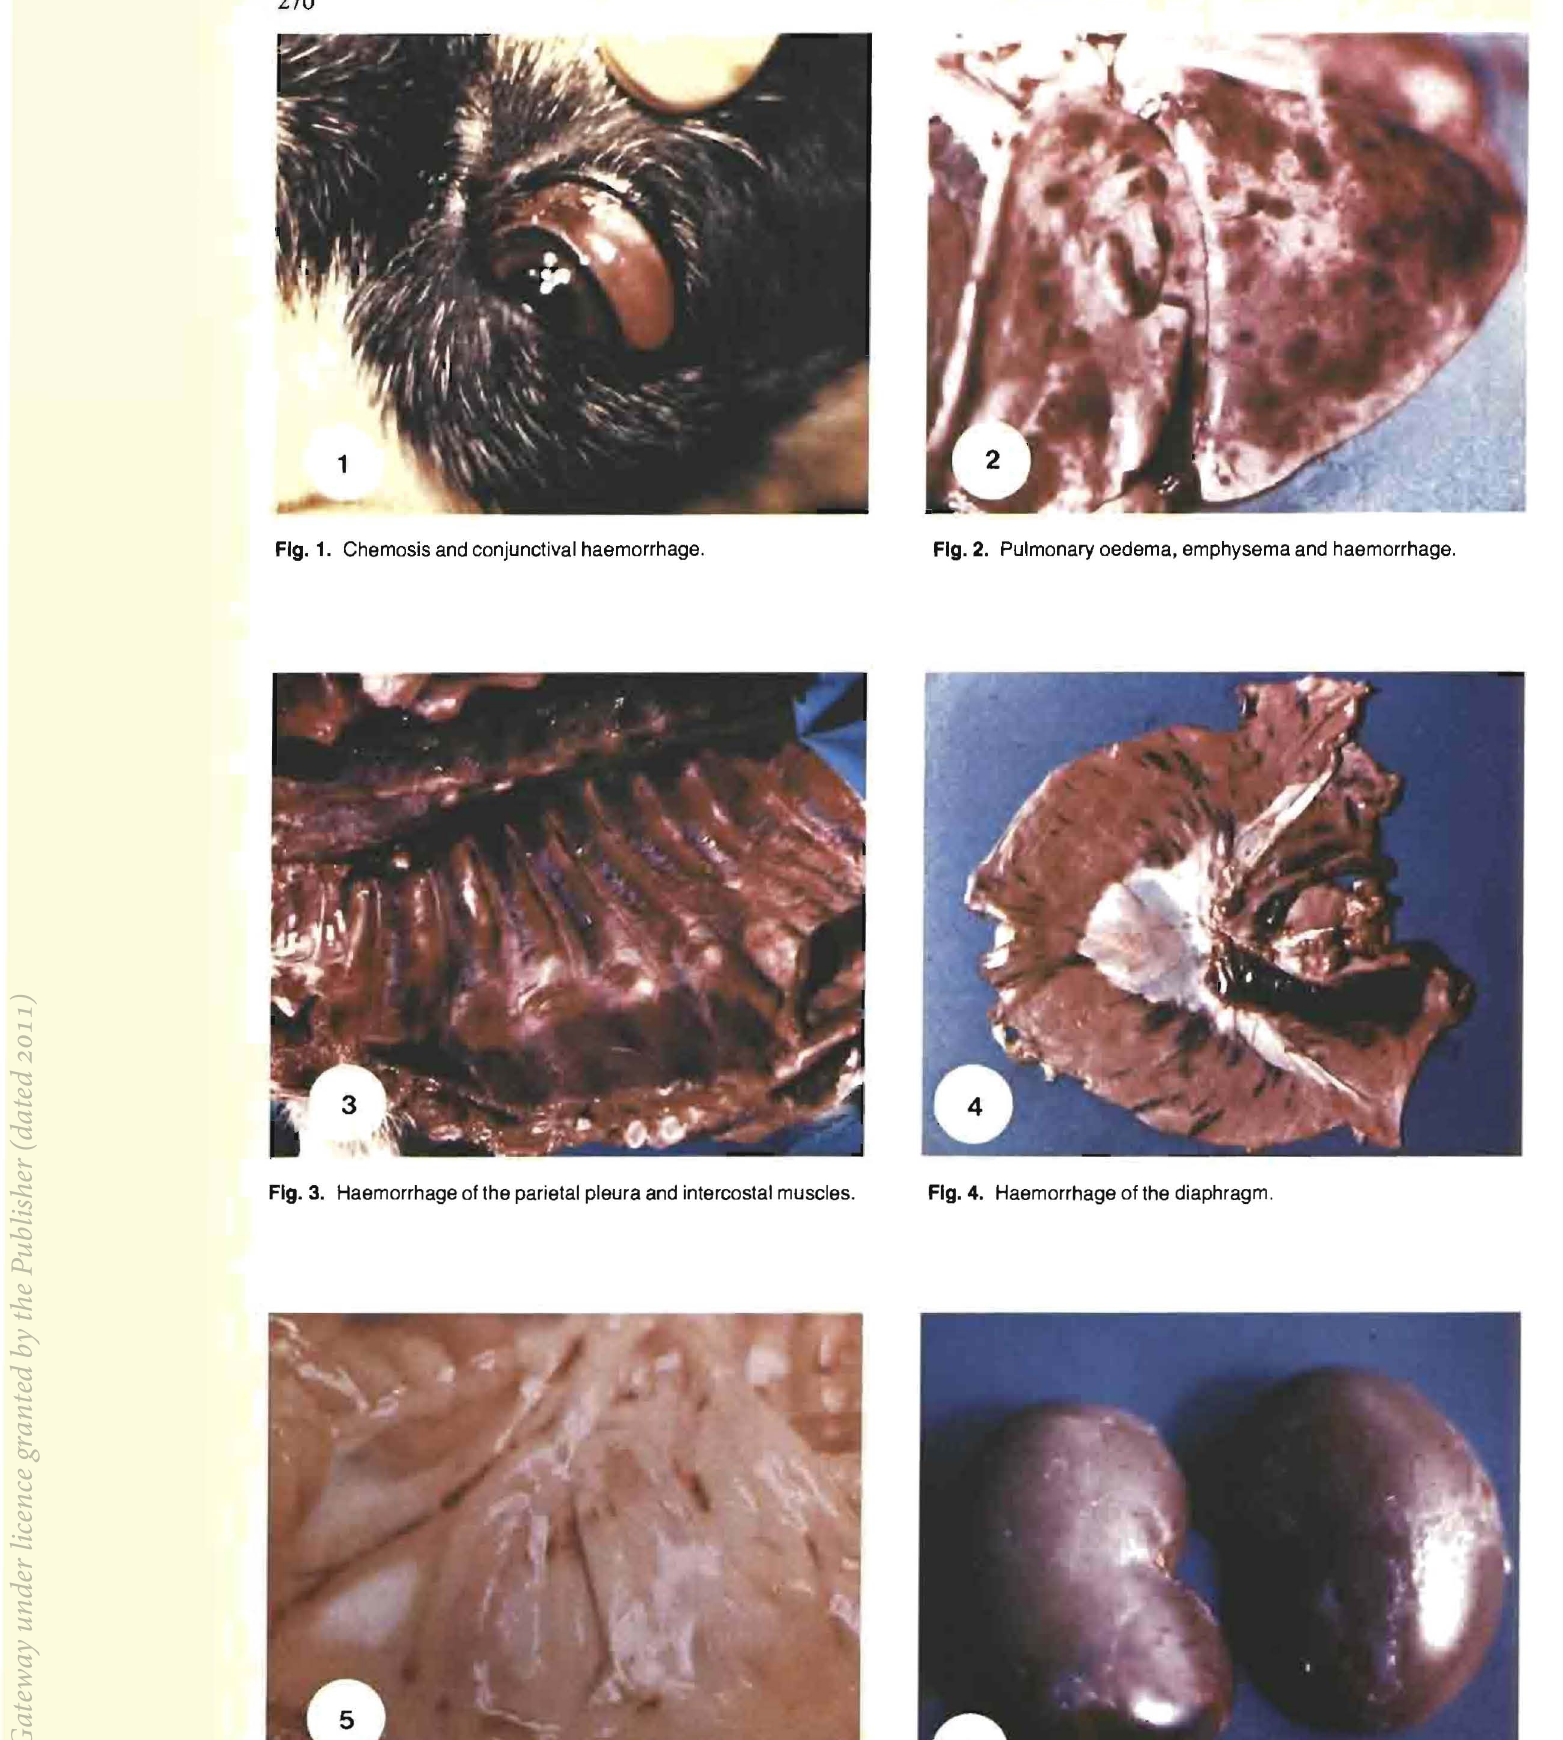
Fig. 5. Haemorrhage of the mesentry.